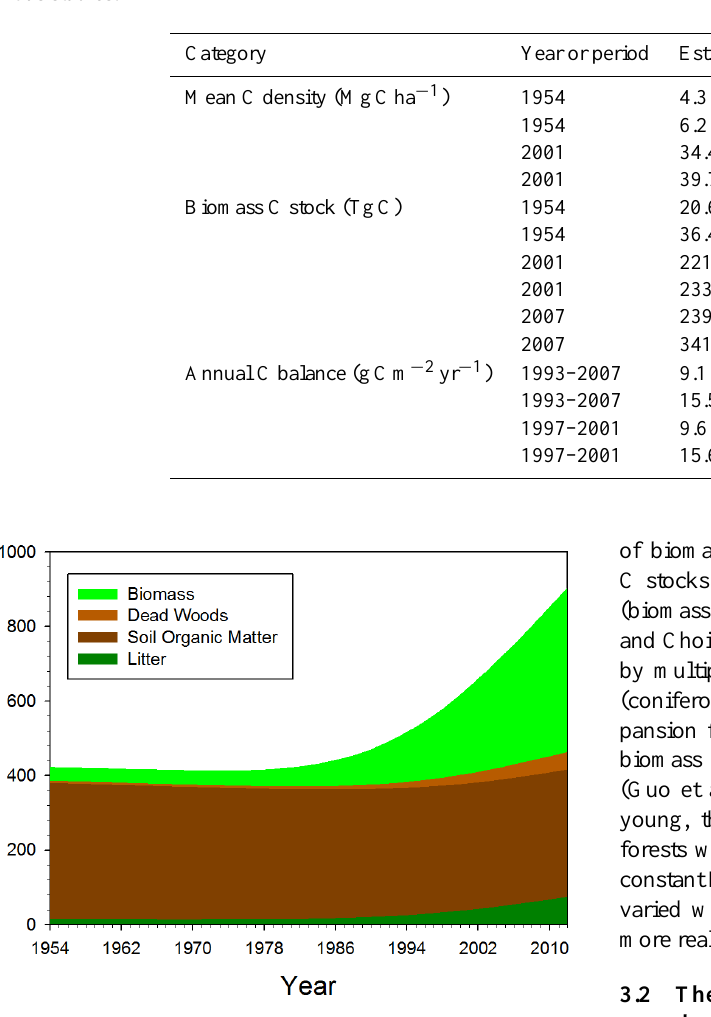
Figure 3. The time series of biomass and dead organic matter (dead woods, soil organic matter, and litter) carbon (C) stocks in South Korean forests during the simulation period. Total C stocks in South Korea have increased as forest vegetation has